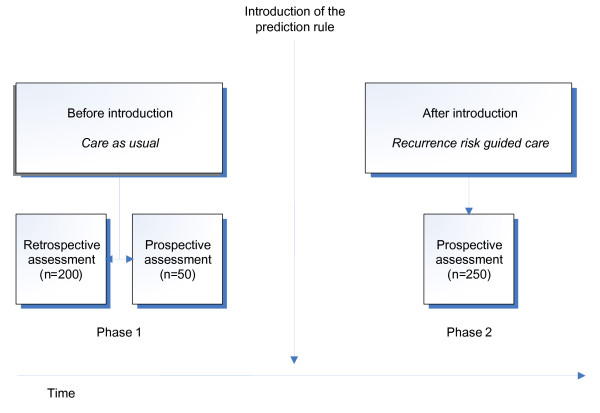
Design of the study.